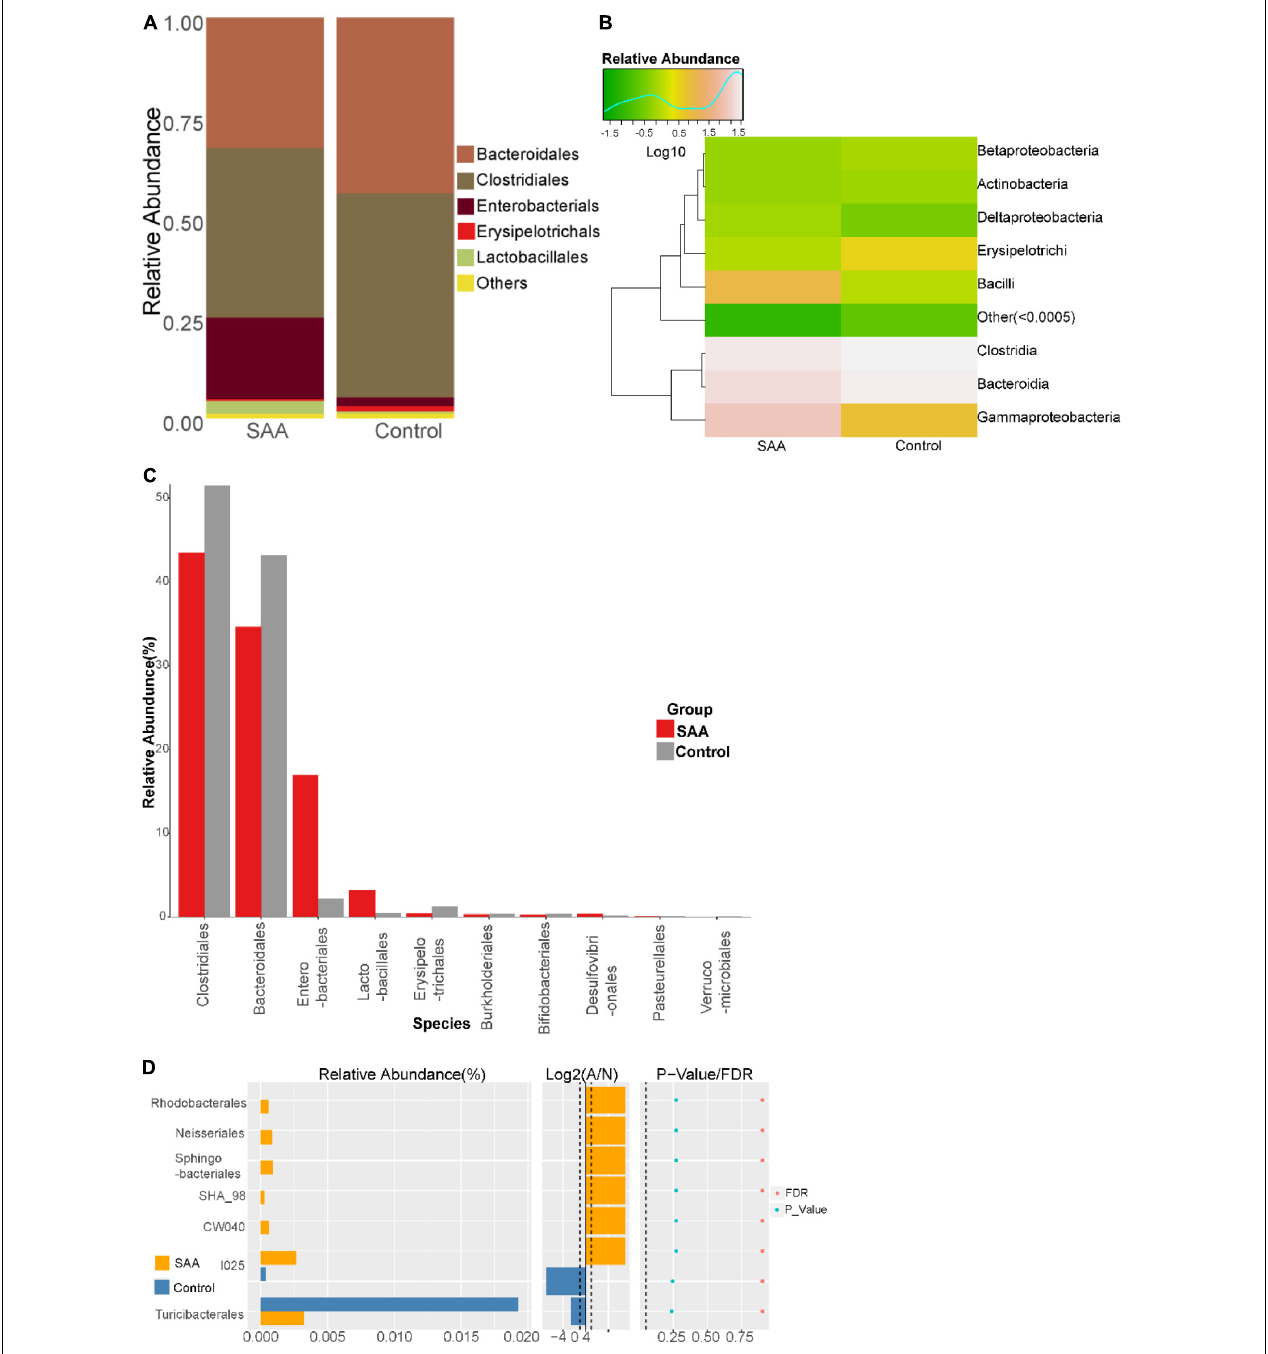
FIGURE 5 | Intestinal microbial compositions of the SAA and control groups at the order level. (A) Bar plot, (B) heatmap, (C) top 10 most abundant species, (D) Wilcoxon rank-sum test results.